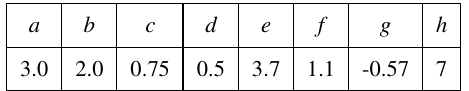
Table 1. Parameters of Goody model.